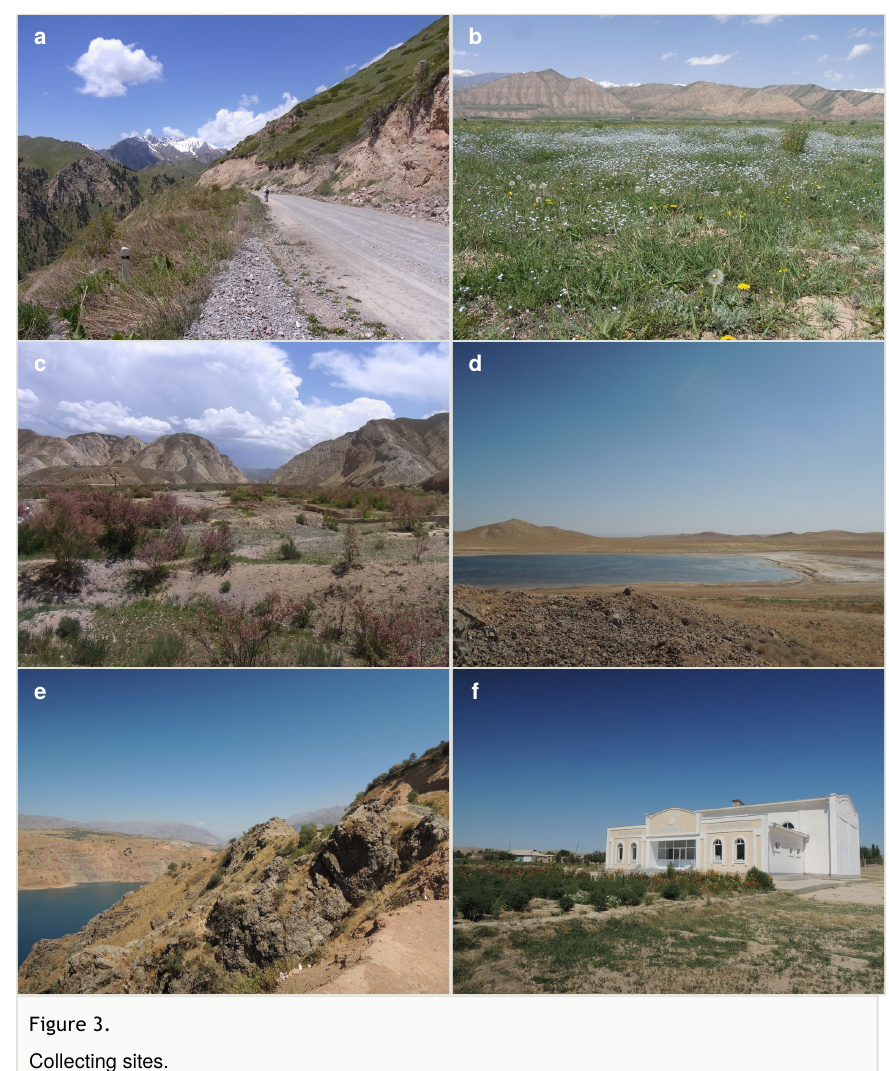
Figure 3. Collecting